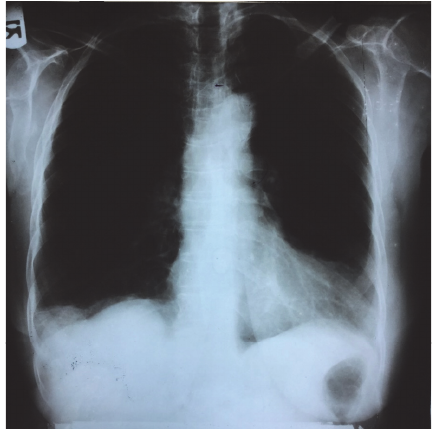
Figure 1: X-ray chest showing right diaphragmatic hernia.